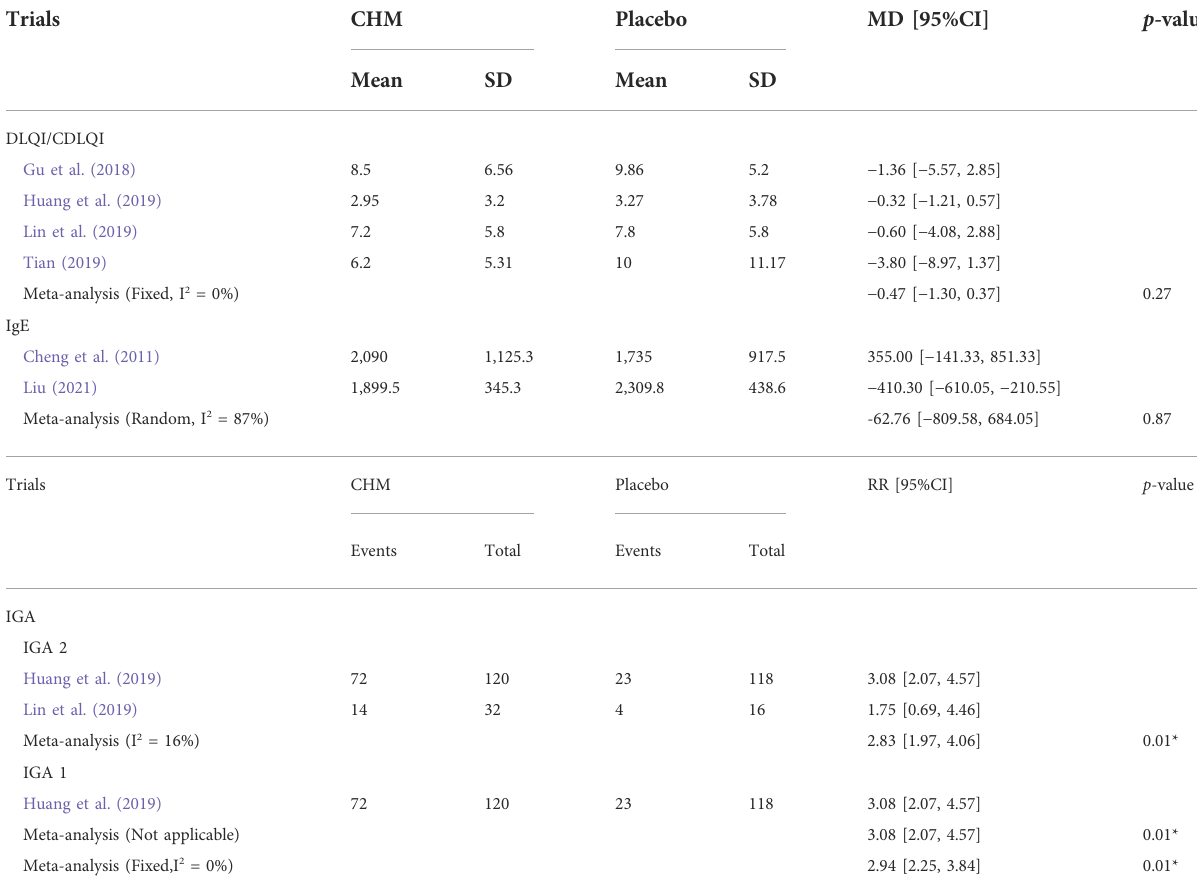
TABLE 4 Other secondary outcome of ef fi cacy between the CHM and placebo